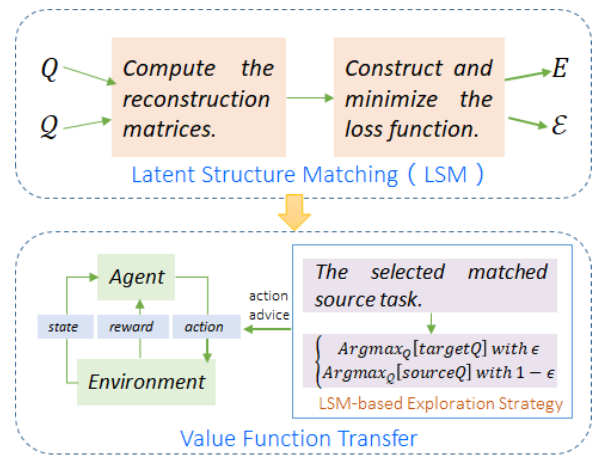
Figure 1. Overview of the two-staged method composed of latent structure matching and value function transfer. In the first stage, latent structure matching (LSM) is used to measure the similarity between tasks, so as to find the highly-matched source task for the target task. In the second stage, value function transfer is used to improve the agent’s exploration strategy, thereby improving the agent’s